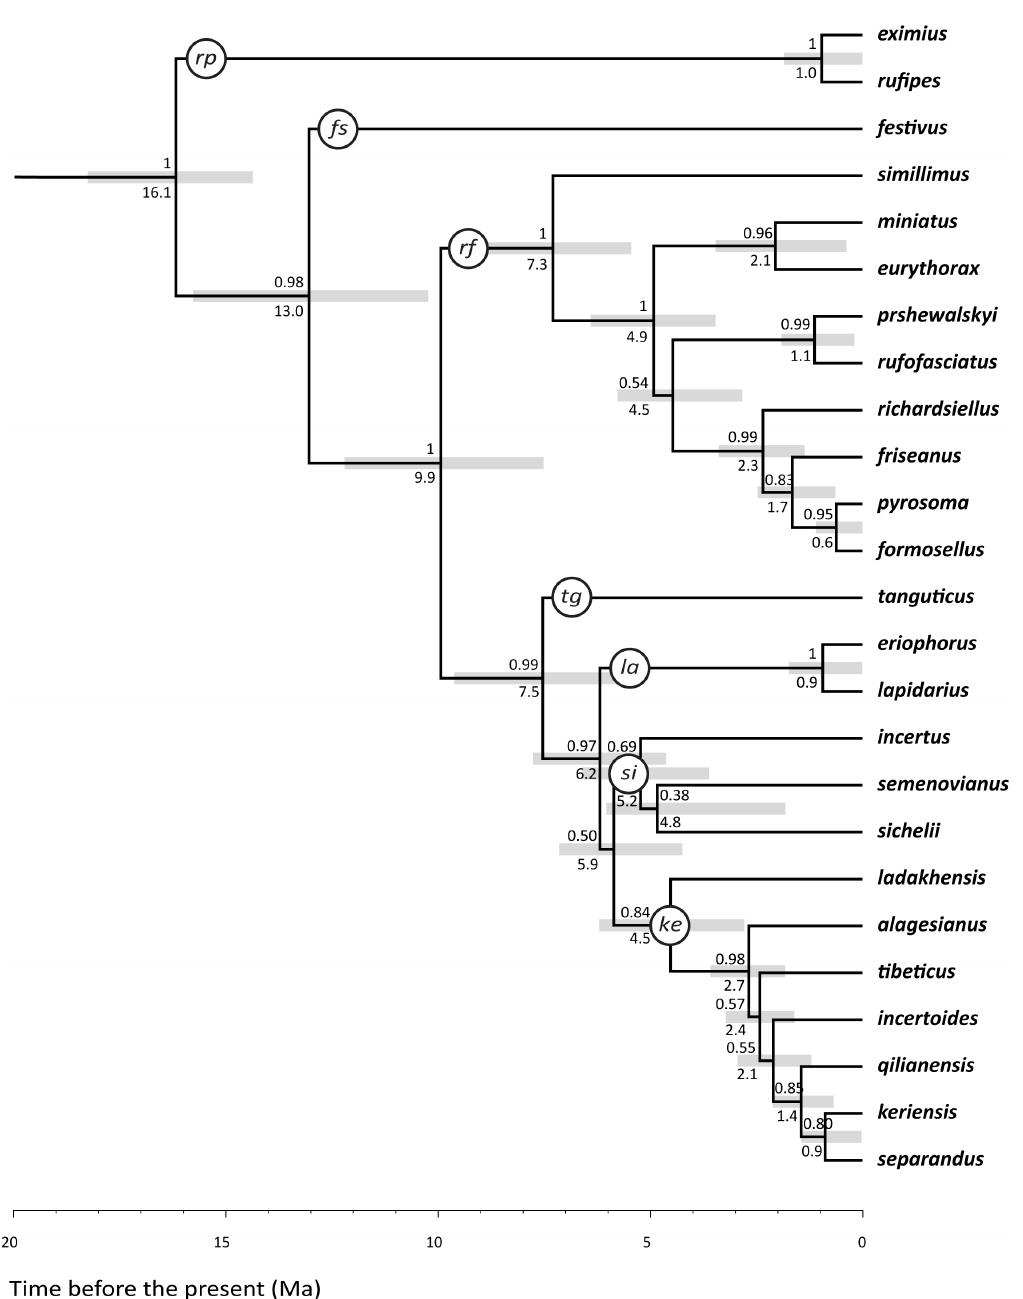
Fig. 22. Most likely dated phylogenetic (ultrametric) tree for the species of the subgenus Melanobombus reconstructed von Dalla Torre, 1880 with *BEAST from trees for four genes (COI, 16S, PEPCK, opsin) with B. nobilis Friese, 1905 as the outgroup (not shown), estimated as the maximum-clade-credibility tree among a sample of 10 000 species trees with a 1% burn-in out of 100 million MCMC trees. Values above the nodes are Bayesian posterior probabilities showing support for groups. Values below the nodes are estimated dates of divergence in Ma (millions of years before the present) calibrated from a molecular estimate for the date of crown divergence within the subgenus Melanobombus . Grey bars show the 95% confidence limits on the estimated dates of divergence. Species groups discussed in the text are labelled in circles: rp = rufipes -group; fs = festivus -group; rf = rufofasciatus -group; tg = tanguticus -group; la = lapidarius -group; si = sichelii -group; and ke = keriensis